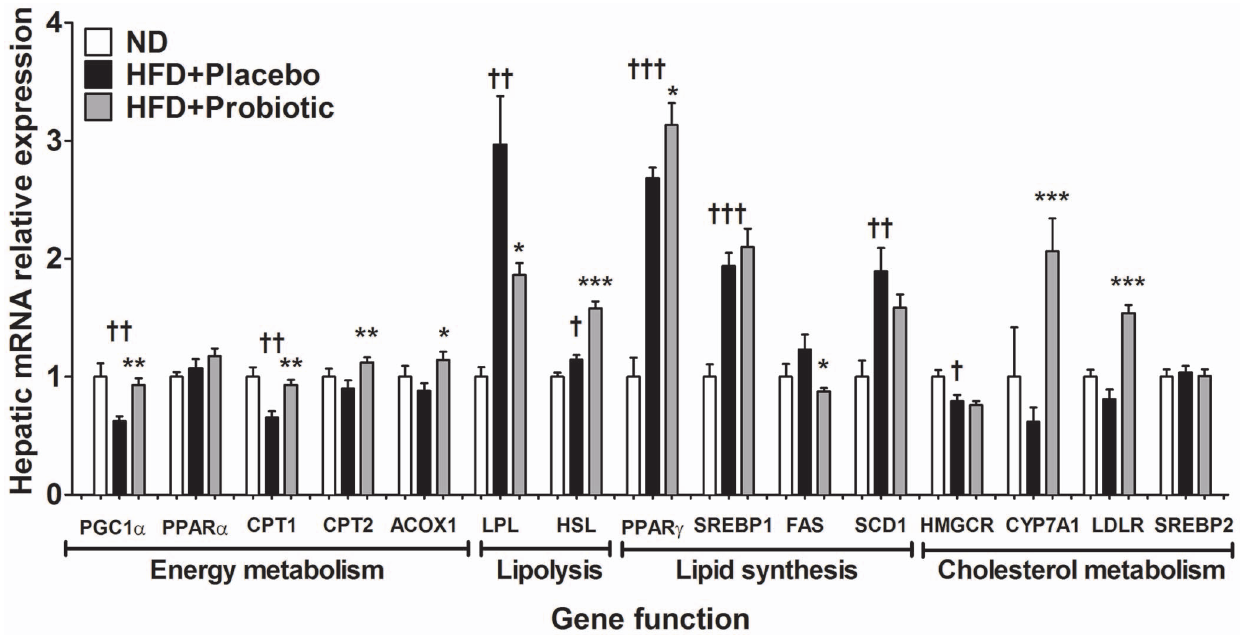
Figure 7. High-fat diet and probiotic effect on gene expression in liver. Results are expressed as the means 6 SE. Significant differences between HFD-placebo versus ND are indicated as { p , 0.05, {{ p , 0.01, {{{ p , 0.001. Significant differences between HFD + probiotic versus HFD + placebo are indicated as *p , 0.05, **p , 0.01, ***p , 0.001.